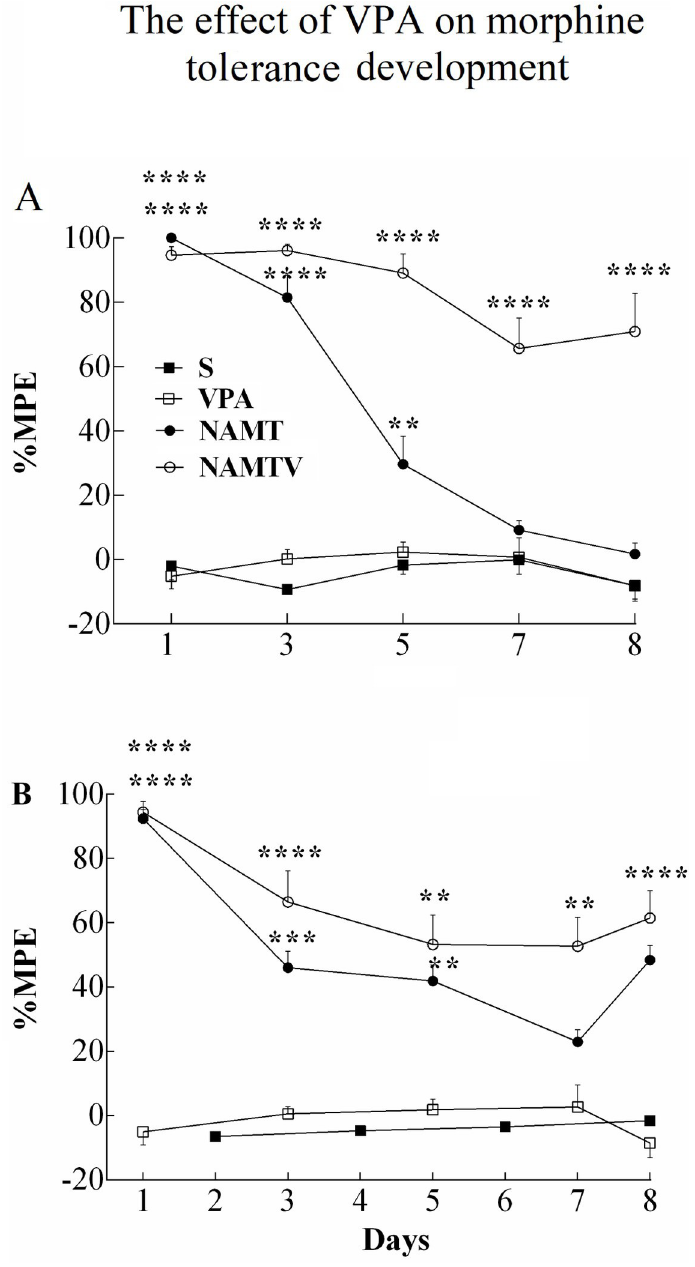
Fig 2. Valproic acid inhibits analgesic tolerance to morphine. Valproic acid was administered 60 min prior to morphine injection. (A-B) Tolerance to morphine was developed by repeated injections, while pretreatment with valproic acid one hour before each morphine injection inhibited the expression of tolerance to morphine. Data are expressed as mean ± S.E.M, �� p < 0.01, ��� p < 0.001, ���� p < 0.0001 as compared to saline (two-way repeated measures ANOVA followed by protected Tukey’s test for multiple comparisons). Maximum Possible Effect (MPE), saline (S), valproic acid (VPA), associative morphine tolerance with valproic acid (AMTV), and non-associative morphine tolerance with valproic acid